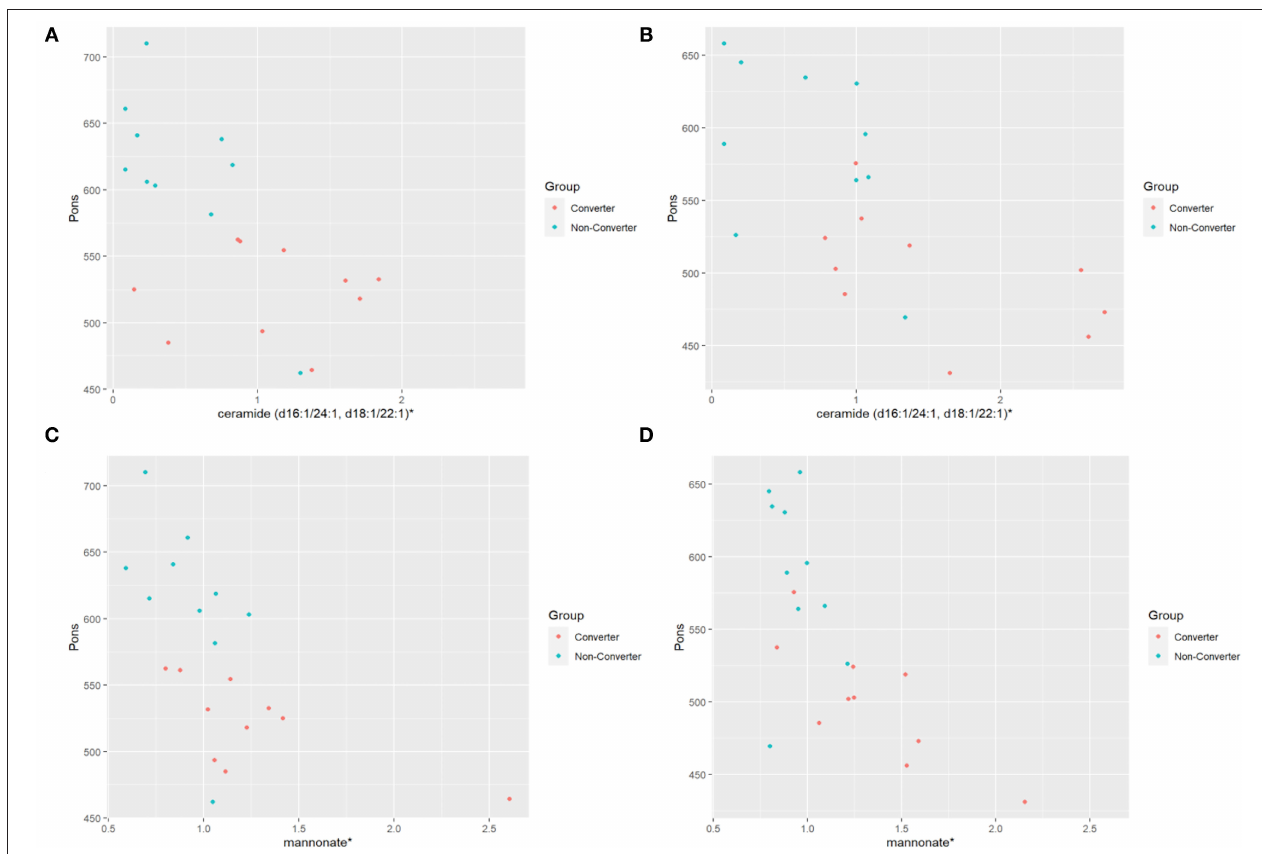
FIGURE 2 | Distribution of metabolic biomarkers with pons between CON and NCON groups. (A) Scatter plots showing correlation between pons and ceramide in CON and NCON at V1. The dots in red are representing the plotted values obtained for CON, and turquoise for NCON. (B) Scatter plots showing correlation between pons and ceramide in CON and NCON at V2. (C) Scatter plots showing correlation between pons and mannonate in CON and NCON at V1. (D) Scatter plots showing correlation between pons and mannonate in CON and NCON at V2. *The identity of these metabolites has not been officially confirmed based on the